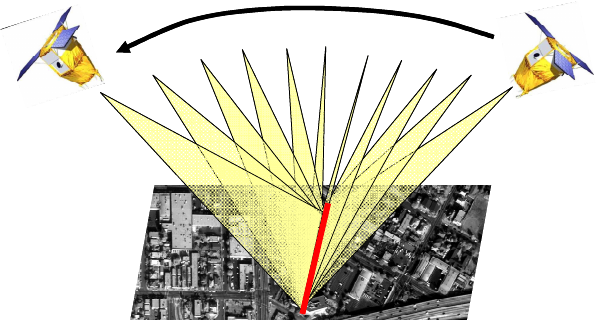
Figure 10. Steady-mode acquisition principle (in red: target landscape